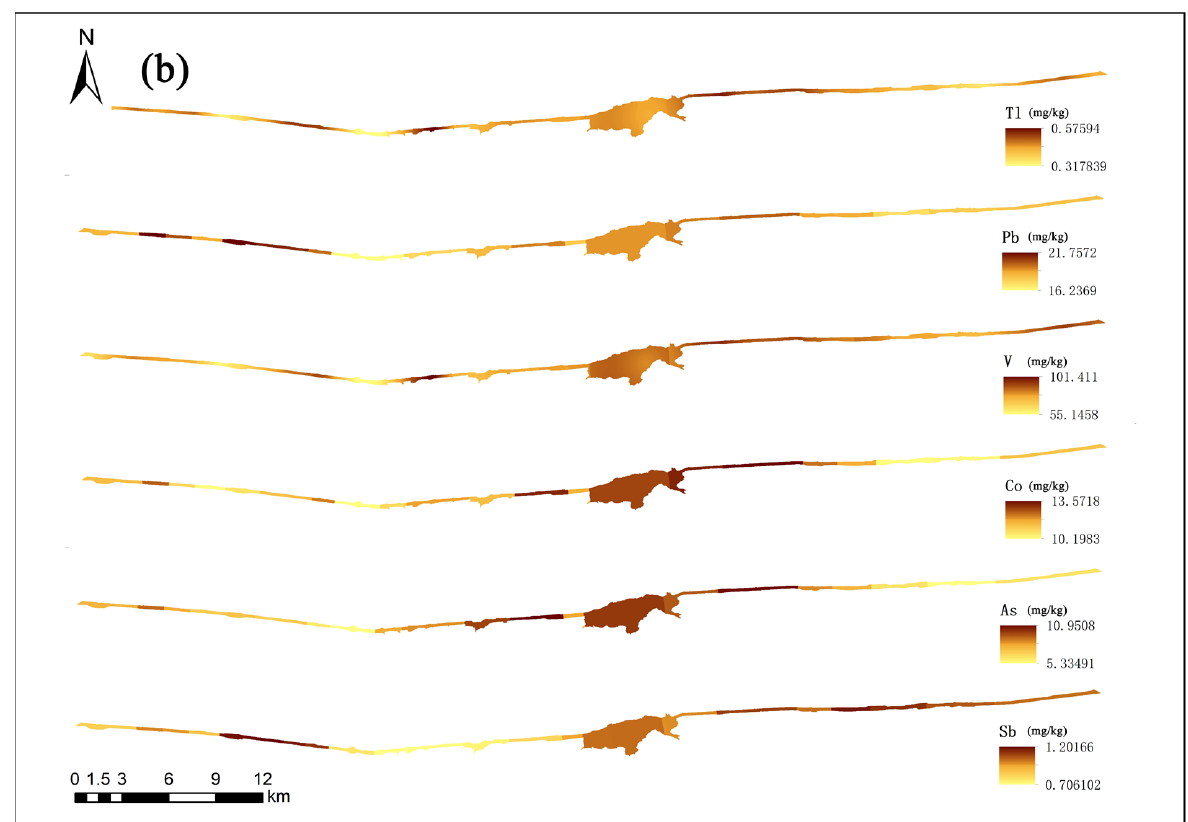
Figure 2. Spatial distribution map of PTEs concentration in sediments of the Taipu River: ( a ) Cr, Ni, Cu, Zn, Mo, Cd; ( b ) Tl, Pb, V, Co, As, Sb.